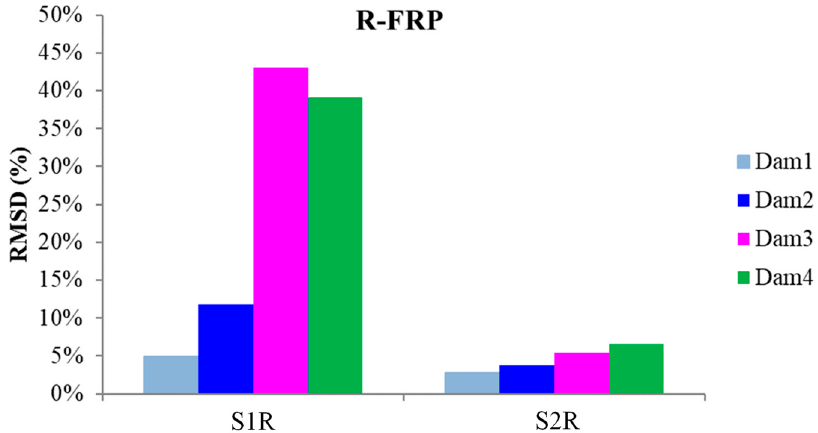
Figure 15. RMSD index values of PTZs mounted on the steel reinforcing bar of R-FRP.